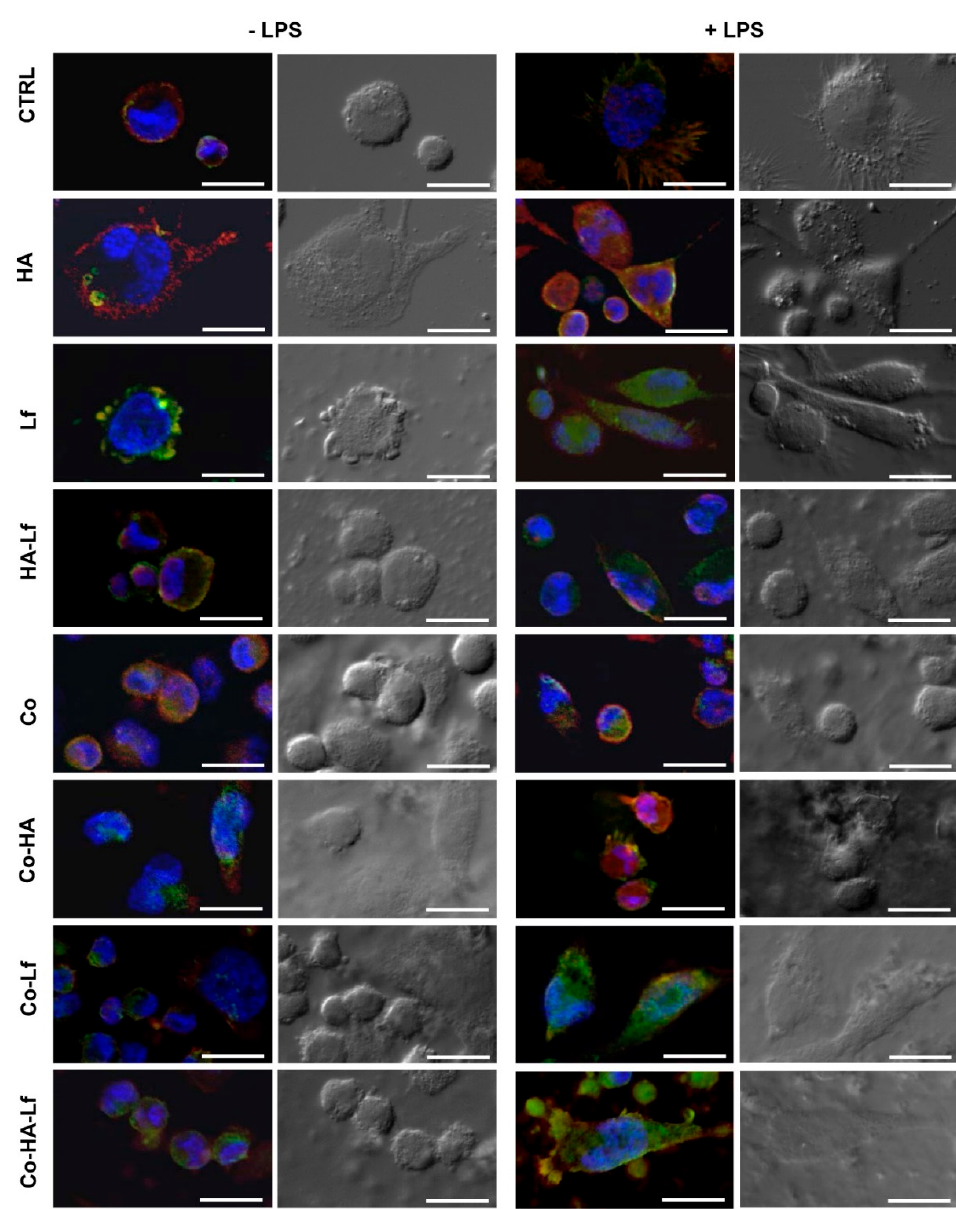
Figure 7. The polarization of differentiated THP-1 cells on biomimetic coatings. Immunofluorescence images (40×) of CCR7 M1 markers (red), CD206 M2 (green) on the cell surface, and nucleus (blue) in the absence (left) and in the presence of (right) lipopolysaccharide (LPS) (Columns 1 and 3). Associated images of optical microscopy (Columns 2 and 4). Scale bar 20 μ m. HA: hydroxyapatite; Lf: lactoferrin.